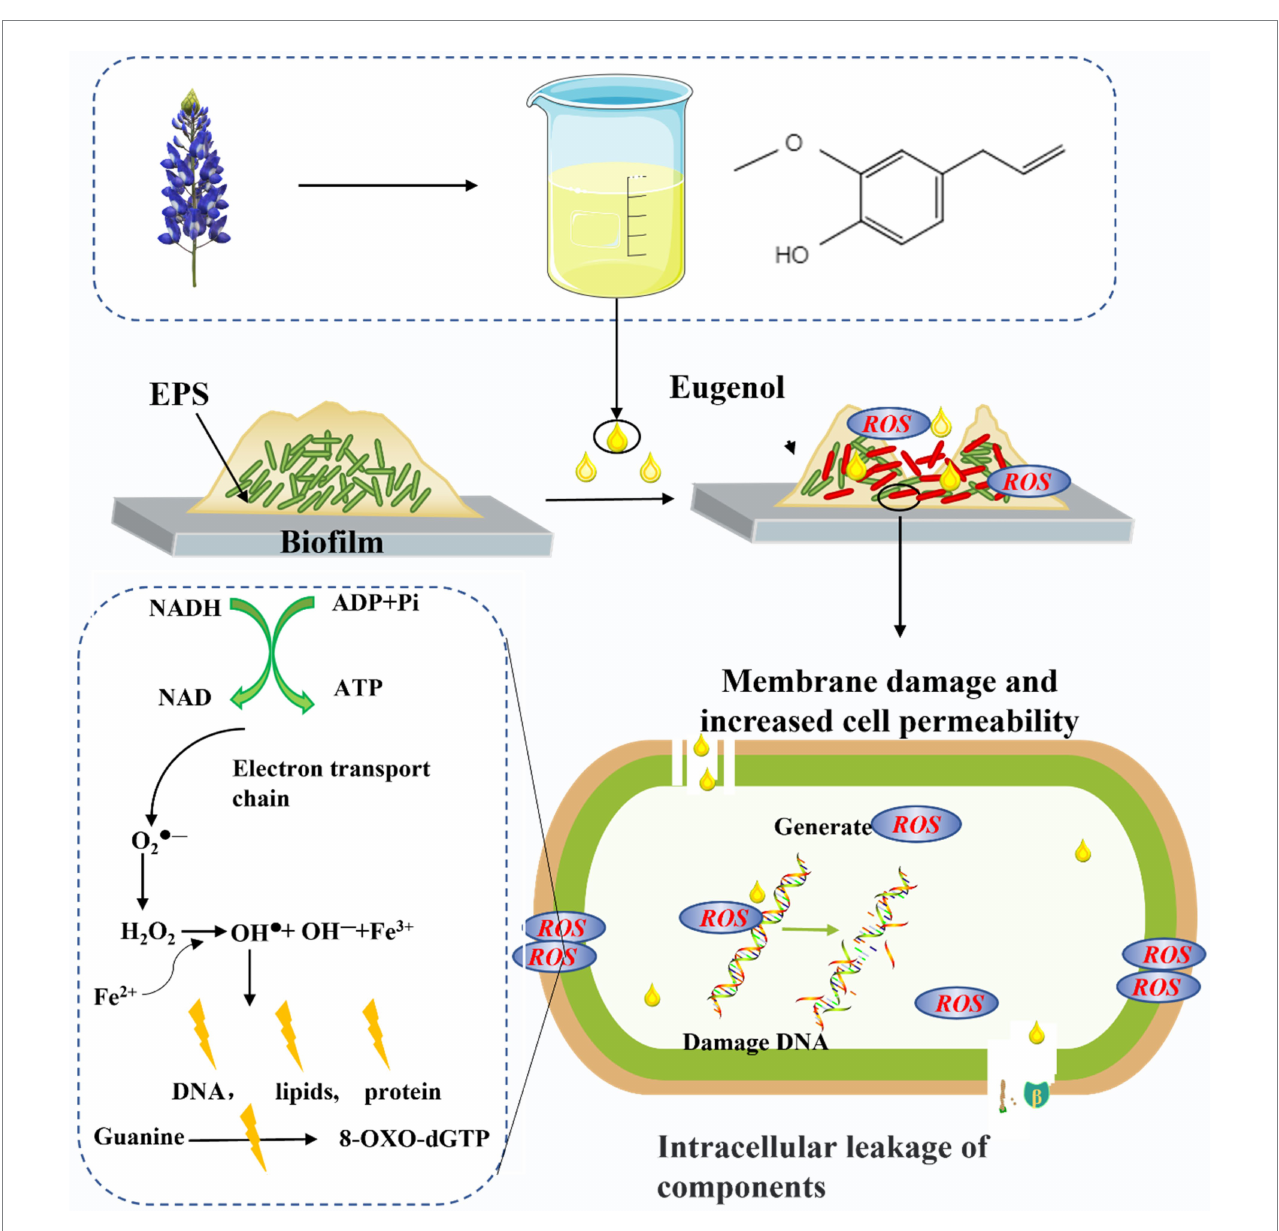
FIGURE 7 Schematic diagram of antibacterial mechanism of